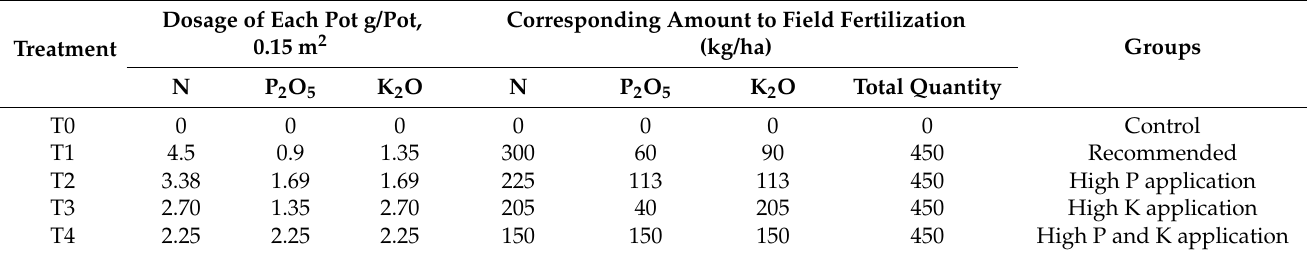
Table 1. Amount of nitrogen (N), phosphorus (P), and potassium (K) applied in the fertilization treatment.